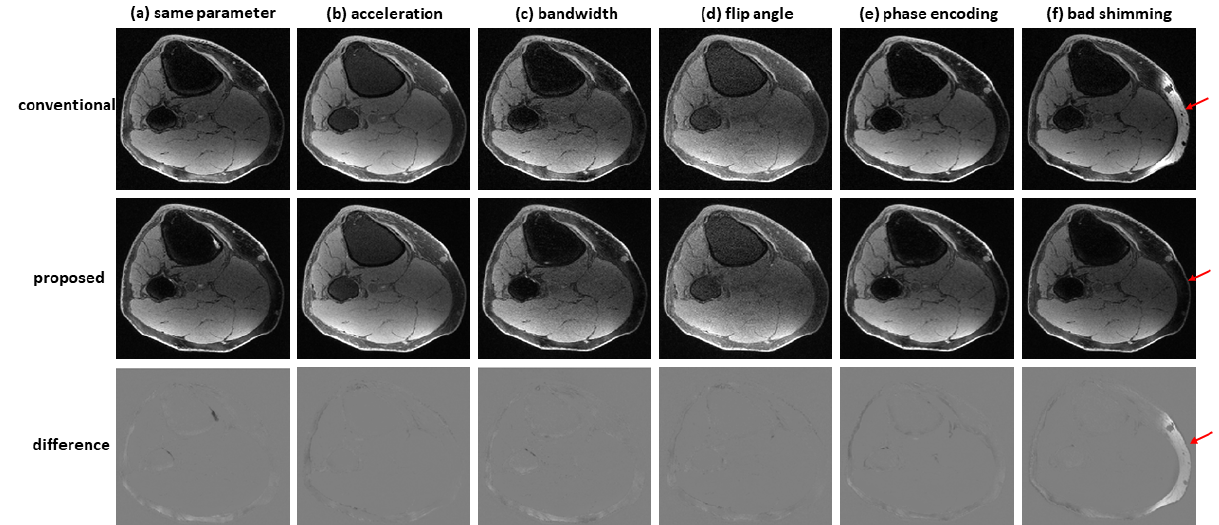
Figure 7. Water–fat separation from non-contrast-enhanced dual-echo images using a model trained with contrast-enhanced images. The non-contrast-enhanced dual-echo images were acquired using ( a ) the same imaging parameters as those adopted in contrast-enhanced studies, ( b ) an acceleration factor of 2, ( c ) bandwidth of 83.3 kHz, ( d ) flip angle of 25°, and ( e ) phase encoding of 224. In these cases, the predicted images had high fidelity to the reference images. ( f ) When bad shimming was intentionally imposed, water/fat swaps that occurred in the reference image were corrected in the predicted image.